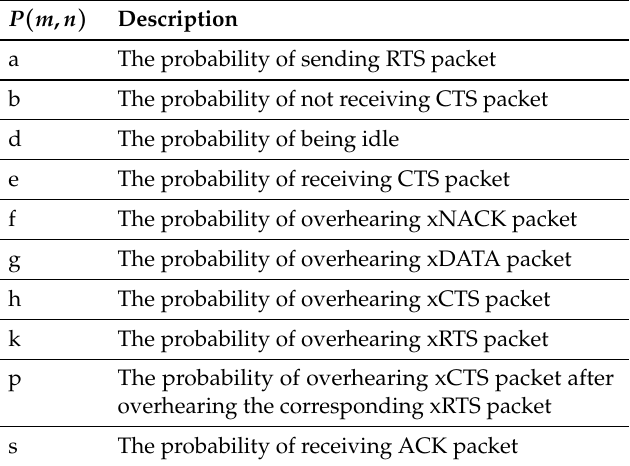
Table 3. State transition